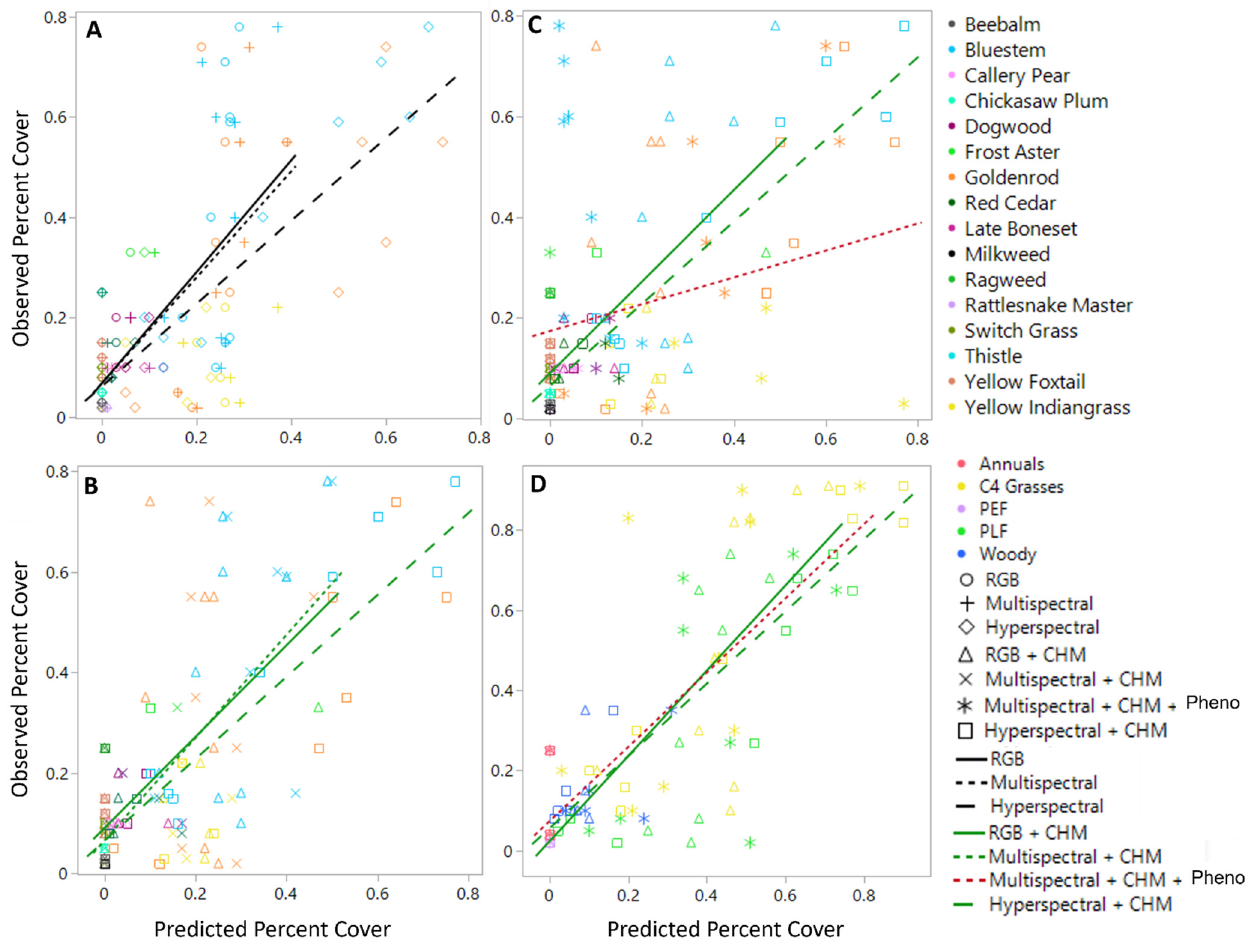
Figure 8. User and producer accuracy results for each sensor-fusion product for plant species and PFTs computed by confusion matrices (available in Supplementary Materials). ( A ) Producer accu- racy for PFTs, ( B ) producer accuracy for species, ( C ) user accuracy for PFTs, and ( D ) user accuracy for species.